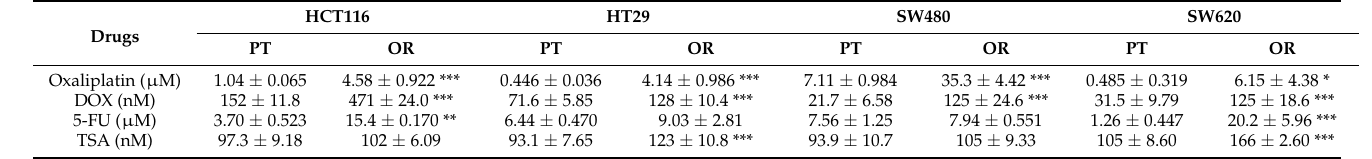
Figure 1. Effects of oxaliplatin on proliferation of the colorectal cancer (CRC) cells. Cell proliferation was estimated by MTT assay in parental (PT, • ) and oxaliplatin-resistant (OR, ○ ) CRC cells of HCT116, HT29, SW480 and SW620. Cells were treated with various concentration of oxaliplatin for 72 h. The data are expressed as mean ± standard deviation of triplicate experiments. The x -axis represents log scale. Table 1. Mean IC 50 ± standard deviation values ( n = 3) of oxaliplatin, DOX, 5-FU and TSA in PT and OR human colorectal cancer cells of HCT116, HT29, SW480 and